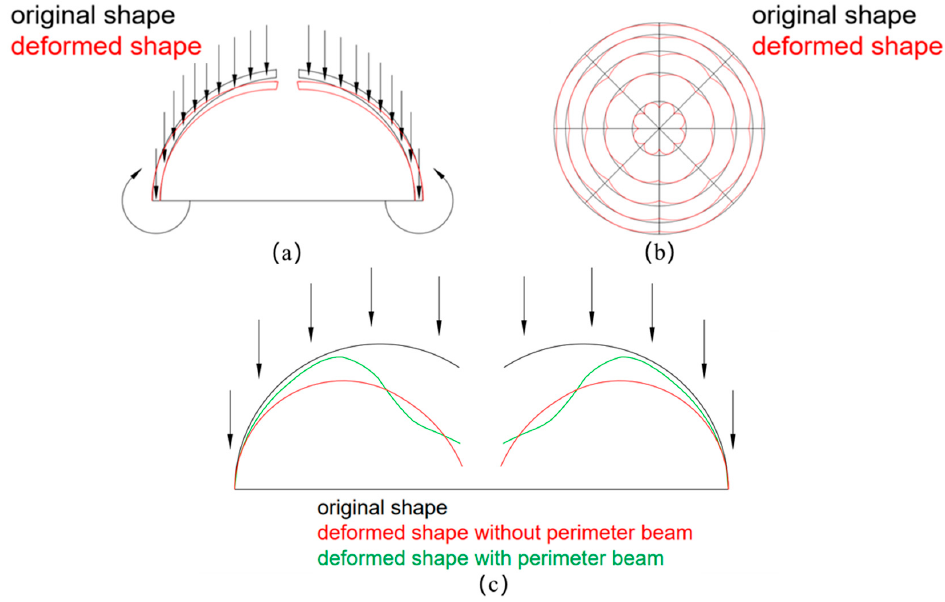
Figure 6. The deformation of the structure under vertical loading: ( a ) load direction demonstration; ( b ) top view of deformation shape; ( c ) front view of deformation shape.